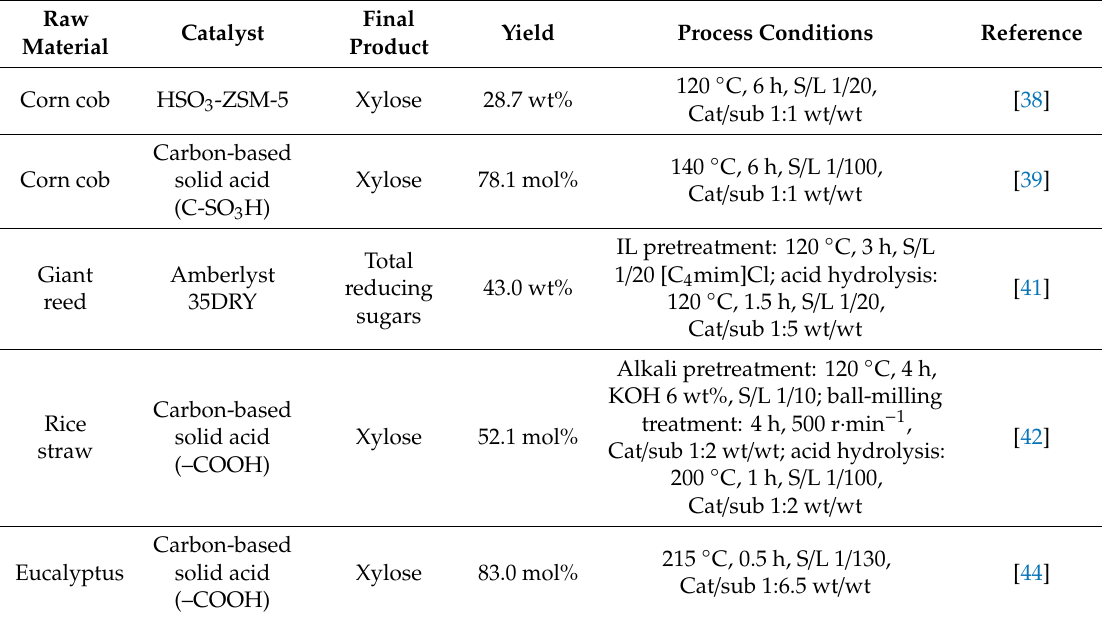
Table 1. Literature review of hemicellulose hydrolysis with heterogeneous catalysts.